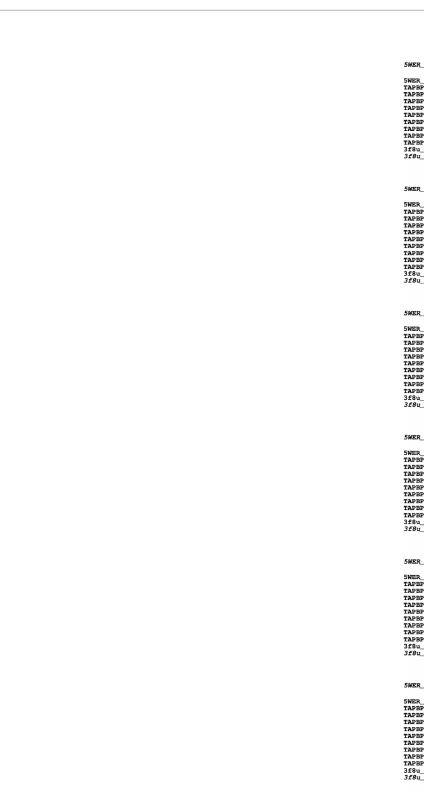
FIGURE 3 | Structure based amino acid sequence alignment of TAPBPR and tapasin (TAPBP) sequences from several different species. Sequences were aligned with ClustalW in MacVector 18.0 and further illustrated with ESPript on the ENDscript server (57). Top and bottom sequences and secondary structure elements are taken from TAPBPR (5WER) and tapasin (TAPBP) (3F8U) respectively. Sequences of TAPBPR_or (orangutan-Pongo abellii-Q5R8H1), TAPBPR_mo (mouse-Mus musculus- Q8VD31), TAPBPR_ra (rat-Rattus novegicus-D4A6L1), and TAPBPR_ze (zebra fi sh-Danio rerio-X1WBD6), as well as TAPBP_gr (gorilla-Chlorocebus aethiops-Q6PZD2), TAPBP_do (dog-Canis lupus familiaris-Q5TJE4), TAPBP_ch (chicken-Gallus gallus-Q9R233), and TAPBP_ze (zebra fi sh-Danio rerio-Q1LUU3) are